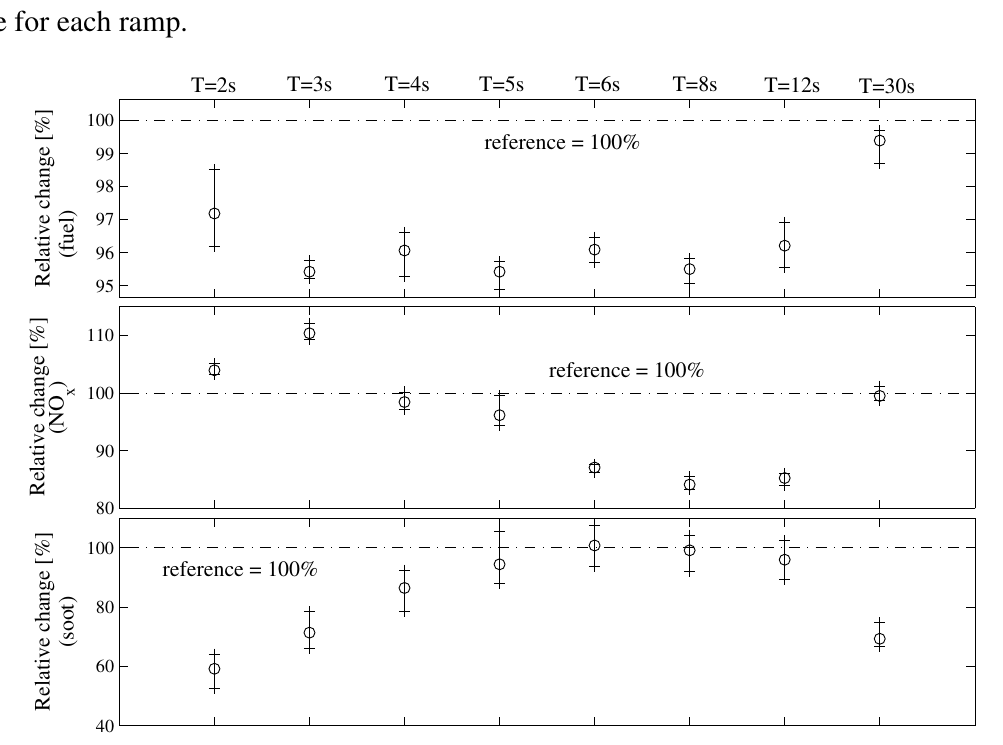
and soot emissions after the x